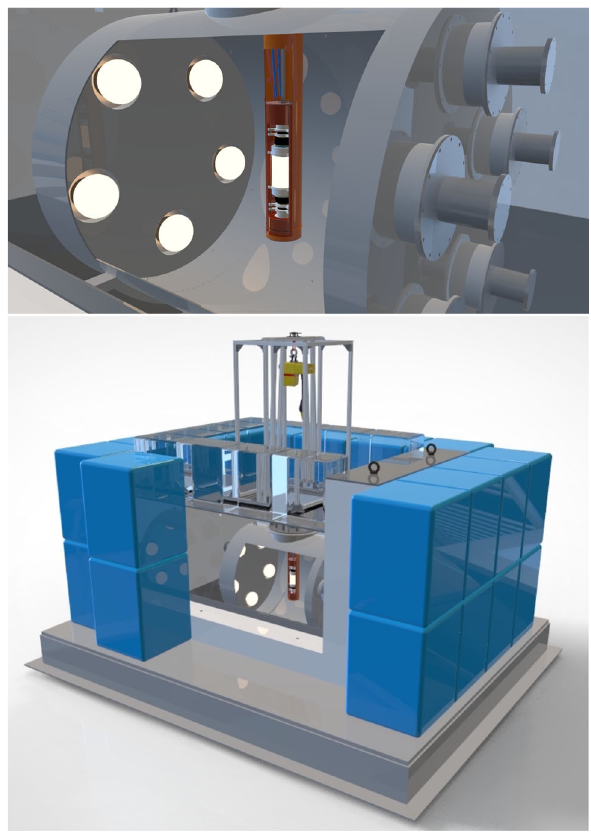
Fig. 2 Top: the SABRE-PoP insertion system. A thin copper tube is connected to the top cover plate of the vessel to provide a dedicated dry volume for the detector module. Bottom: a removable frame is mounted at the top of the vessel to lower the detector module with a motorized pulley into the tube. The vessel is surrounded on each side by polyethylene. On the bottom, the detector is isolated by lead layers, while the sides and the roof are shielded by water